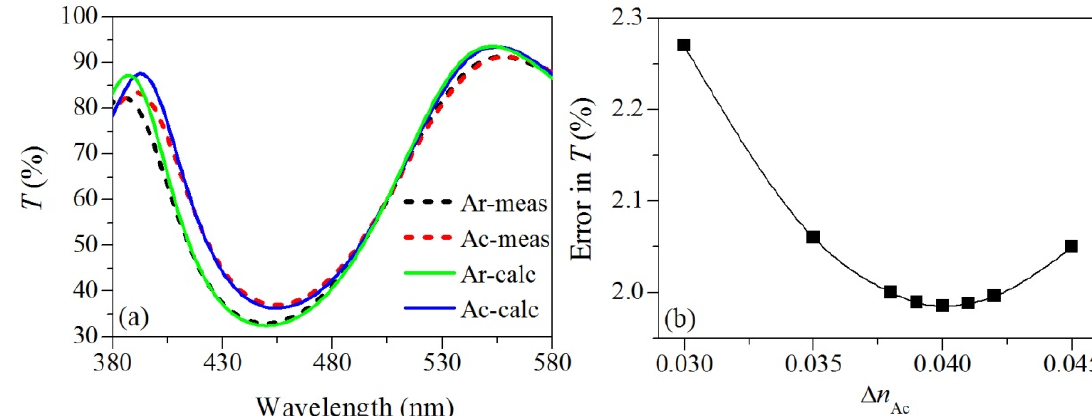
Figure 6. ( a ) Calculated and measured transmittance spectra of 7-layer stacks consisting of dense Nb 2 O 5 as high refractive index medium and mesoporous Nb 2 O 5 obtained using Pluronic PE6200 as a low refractive index medium in argon and acetone ambient; ( b ) Dependence of fitting error on refractive index change ∆ n Ac generated by acetone vapor condensation.